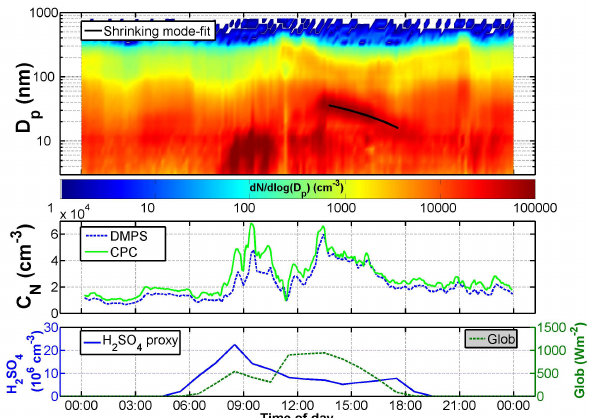
Fig. 5. Class II type event during morning hours and a shrinking mode in the early afternoon on 12 October 2010. The evaporation rate of the shrinking mode was calculated to be 5.2nmh − 1 (upper panel). The split between NAIS and DMPS data in the picture is at 15nm. During the evaporation (from 14:00 to 17:00 LT) the total particle concentration ( C N ) declines constantly (middle panel). In the middle panel, DMPS concentrations between 6 and 800nm and CPC concentrations between 5nm and 2.5µm are shown. The lower panel shows the H 2 SO 4 proxy concentration, and global irradiance (Glob).